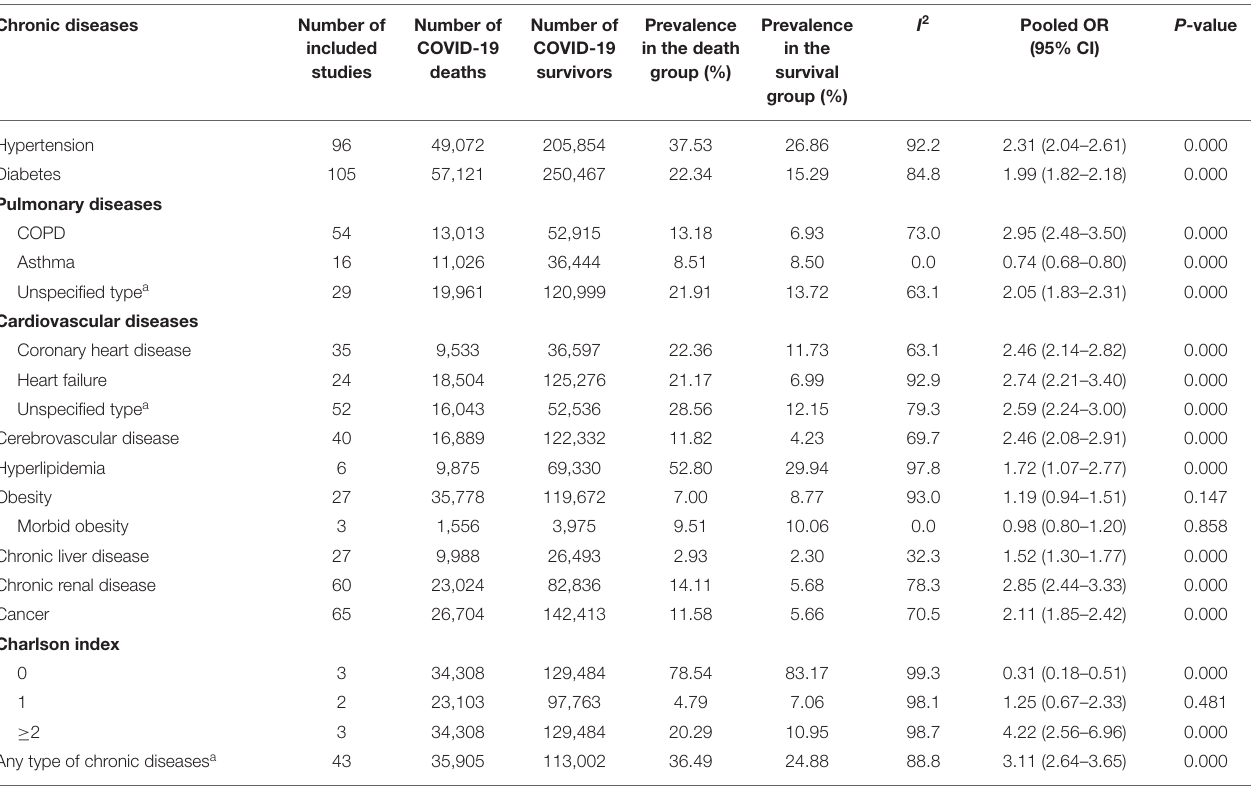
TABLE 3 | Associations between chronic diseases and mortality of